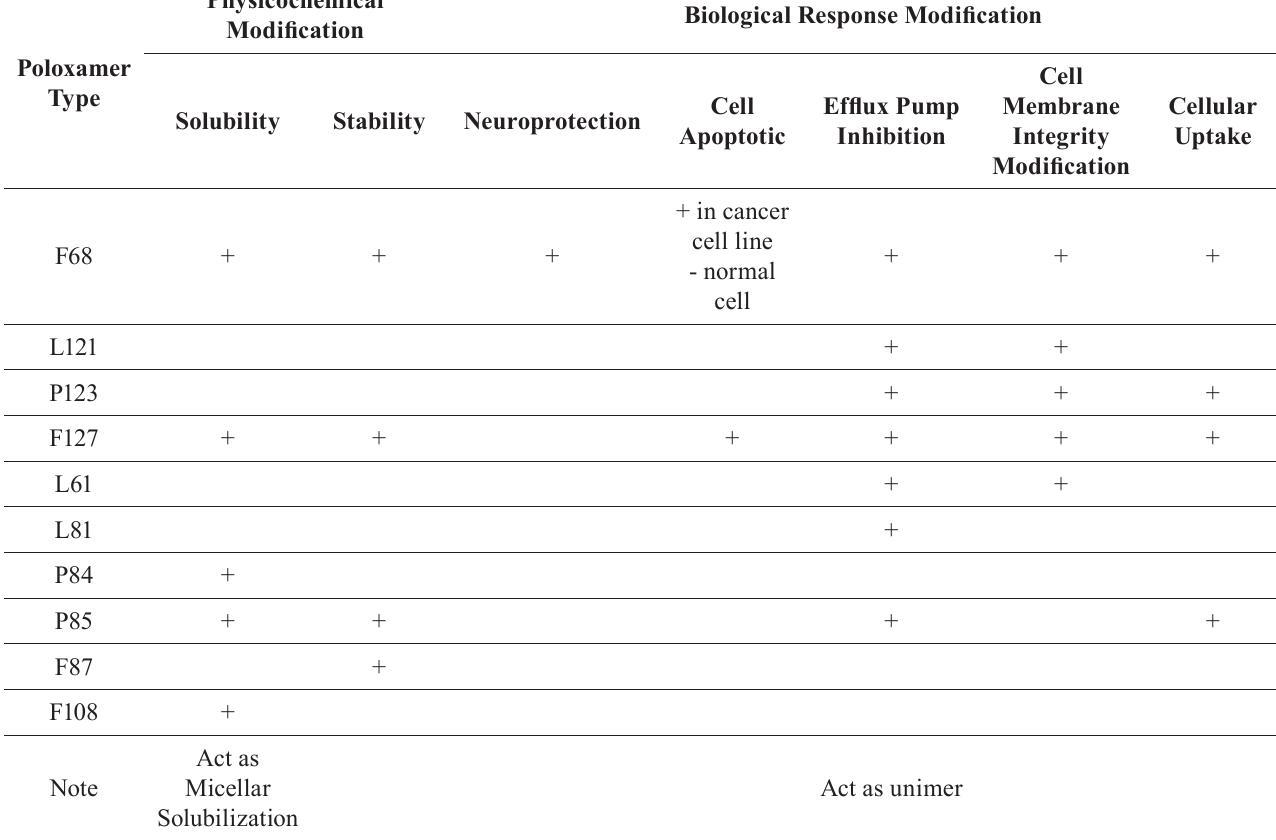
TABLE I - L ist of Poloxamers and Functionalities